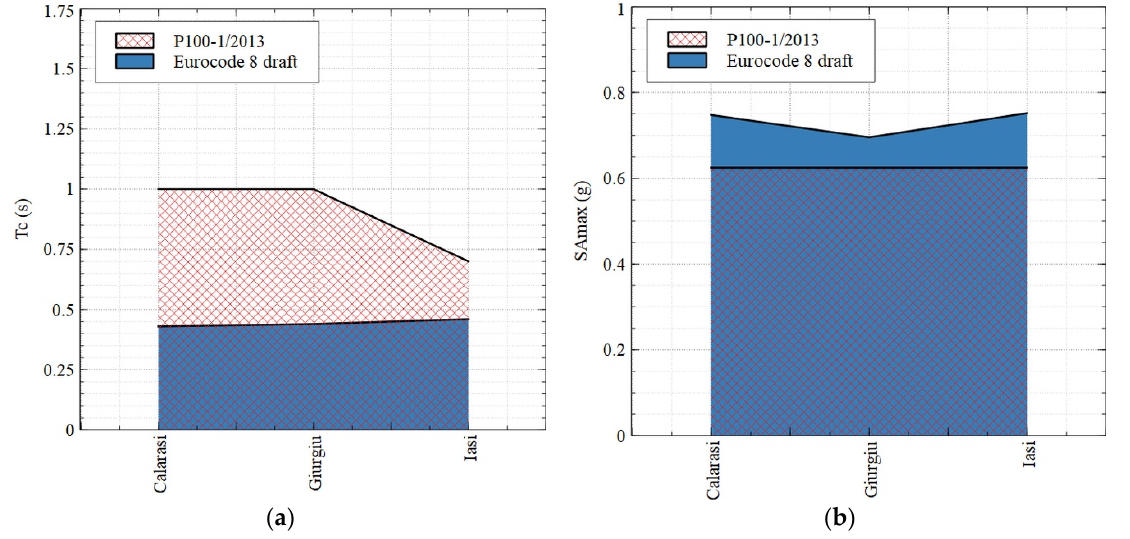
Figure 5. ( a ) A comparison between the control period T C from P100-1/2013 [29] and based on Eurocode 8 draft revision [1] for category C sites; ( b ) a comparison between the maximum spectral acceleration from P100-1/2013 [29] and based on Eurocode 8 draft revision [1] for category C sites.